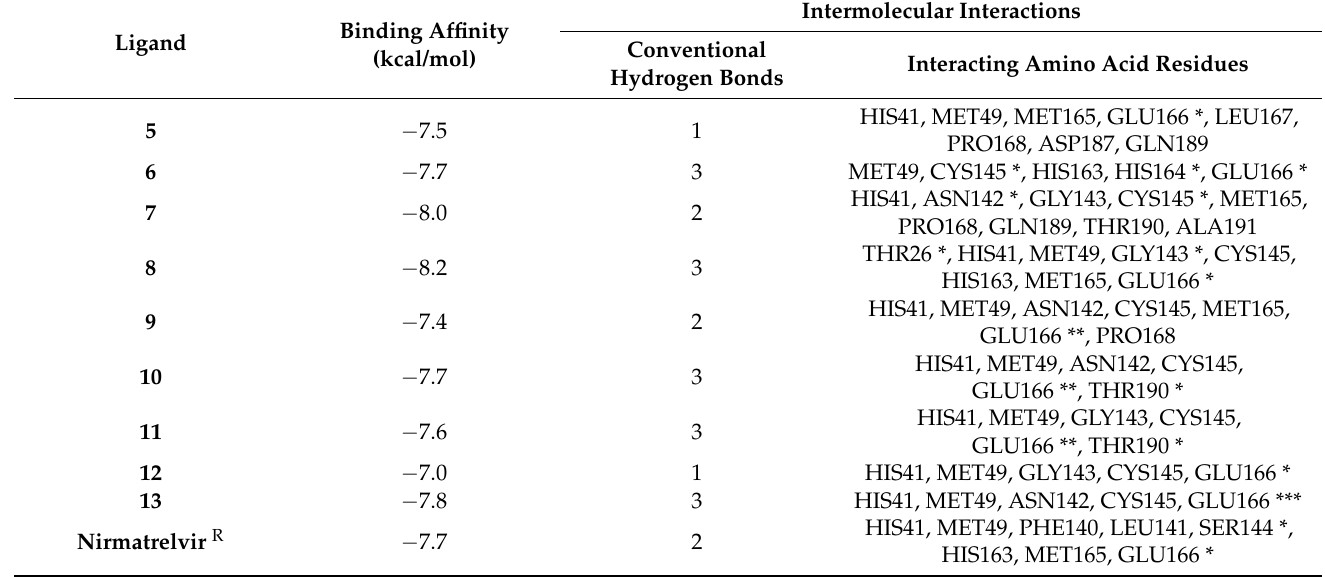
Table 1. Ligand and receptor (Omicron) interactions: binding affinity, number of conventional hydrogen bonds and interacting amino acid